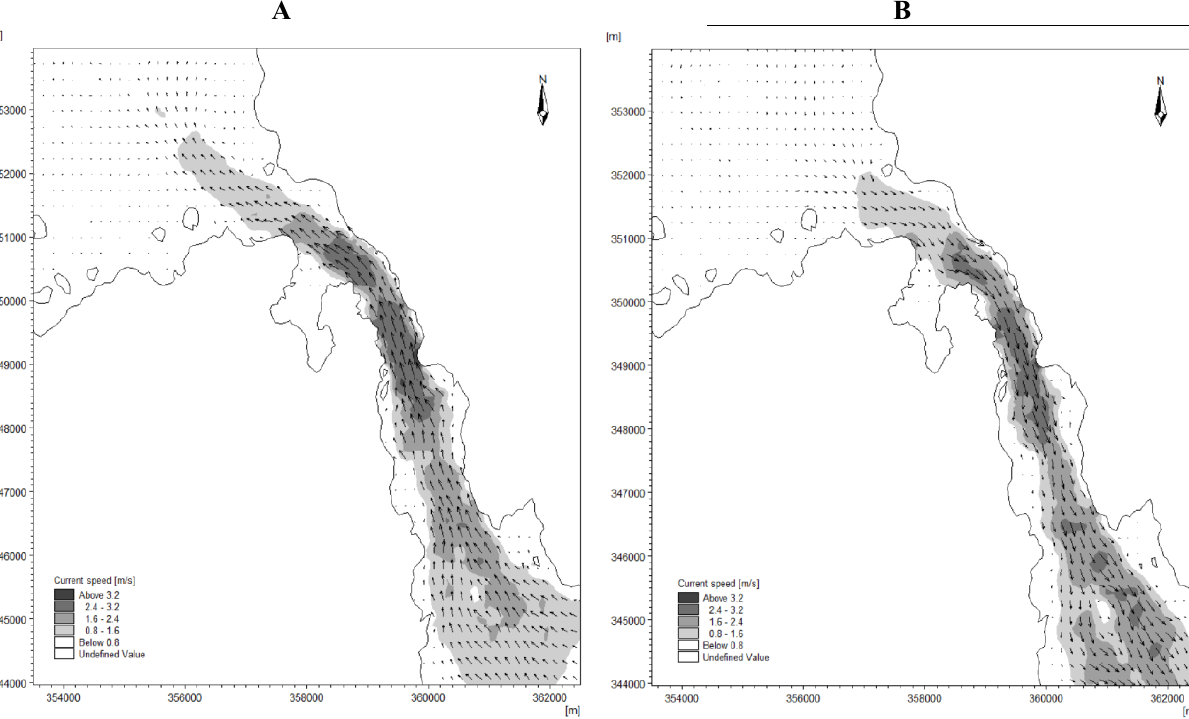
Figure 10. Depth averaged maximum flow during flood ( A ) and ebb ( B ) tide in the Narrows, Strangford Lough. A